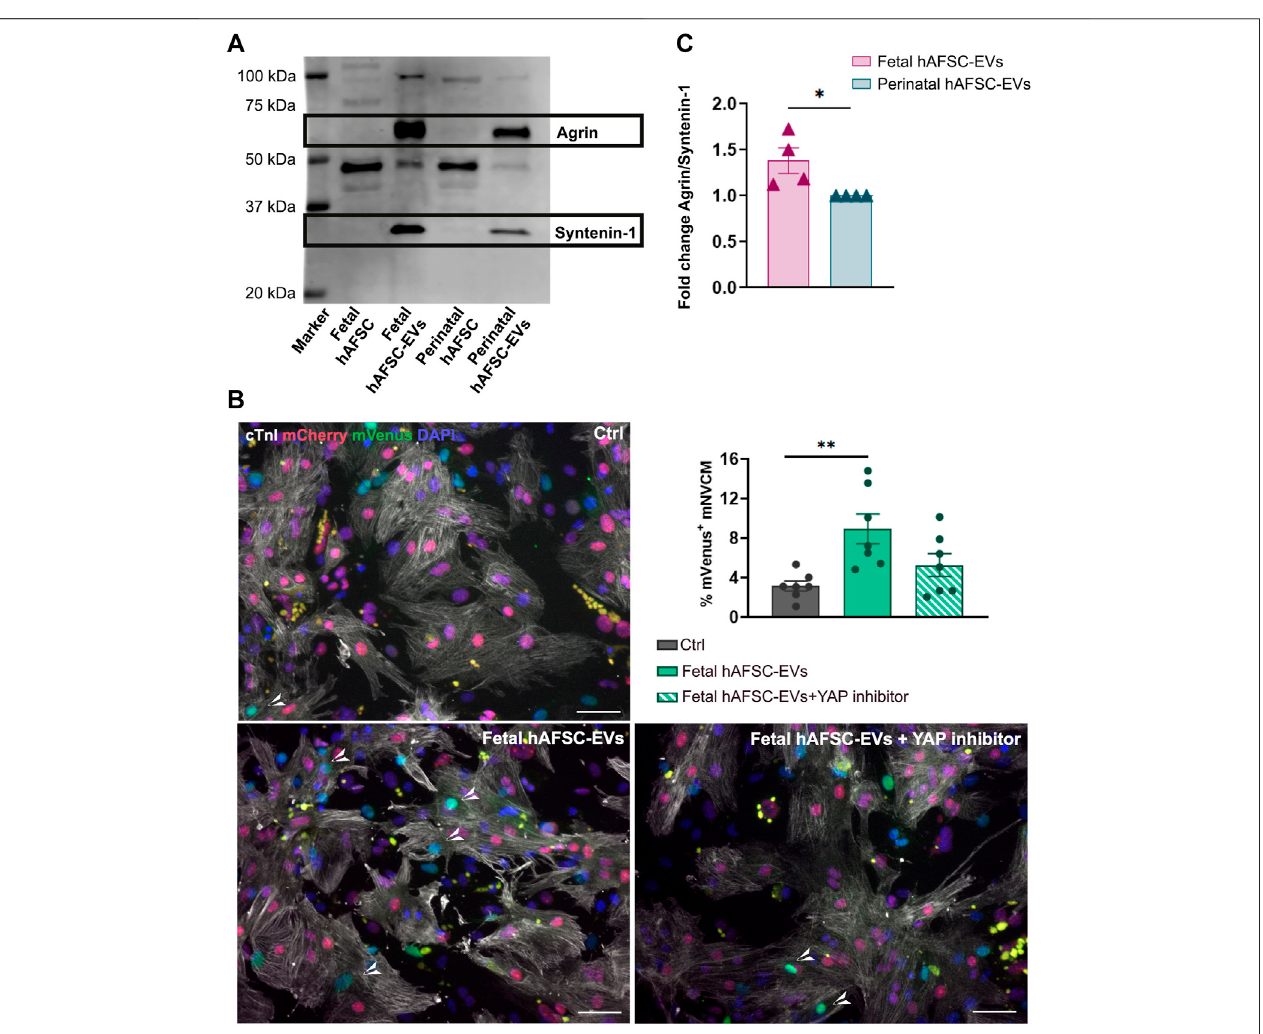
FIGURE 6 | Agrin as molecular candidate of hAFSC-EV effect on mNVCM. (A) Left panel: representative Western blot of Agrin expression within fetal hAFSC-EVs over perinatal hAFSC-EVs, normalized to the presence of the small EV marker Syntenin-1; right panel: densitometry analysis of protein band signal by Agrin over Syntenin-1 – foldchangeexpressionasmean±s.e.m.(FoldChangeAgrin/Syntenin-1)of n =4independentexperiments(fetalhAFSC-EVs:1.38±0.14;perinatalhAFSC- EVs as calibrator: 1; * p = 0.0348). (B) Representative images of R26pFUCCI2 +/ − mNVCM following treatment with fetal hAFSC-EVs with or without YAP pathway inhibitor (10 μ M Verterpor fi n solution) or in vehicle-treated control condition (PBS solution, Ctrl) by immunostaining for cardiac troponin I (cTnI, white); mCherry-Cdt1 (mCherry, red), mVenus-Geminin (mVenus, green) and DAPI (blue), scale bar: 50 µm. (C) Percentage of mVenus-positive and cTnI-positive cells (mVenus + mNVCM) stimulated with fetal hAFSC-EVs alone or with YAP inhibitor (fetal hAFSC-EVs + YAP inhibitor) compared to vehicle-treated cells (PBS solution, Ctrl). All values are expressed as mean ± s.e.m. percentage of mVenus + mNVCM (% mVenus + mNVCM) of n = 7 independent experiments (Ctrl: 3.14 ± 0.50%; fetal hAFSC-EVs: 8.92 ± 1.50%; fetal hAFSC-EVs + YAP inhibitor: 5.27 ± 1.15%; ** p =